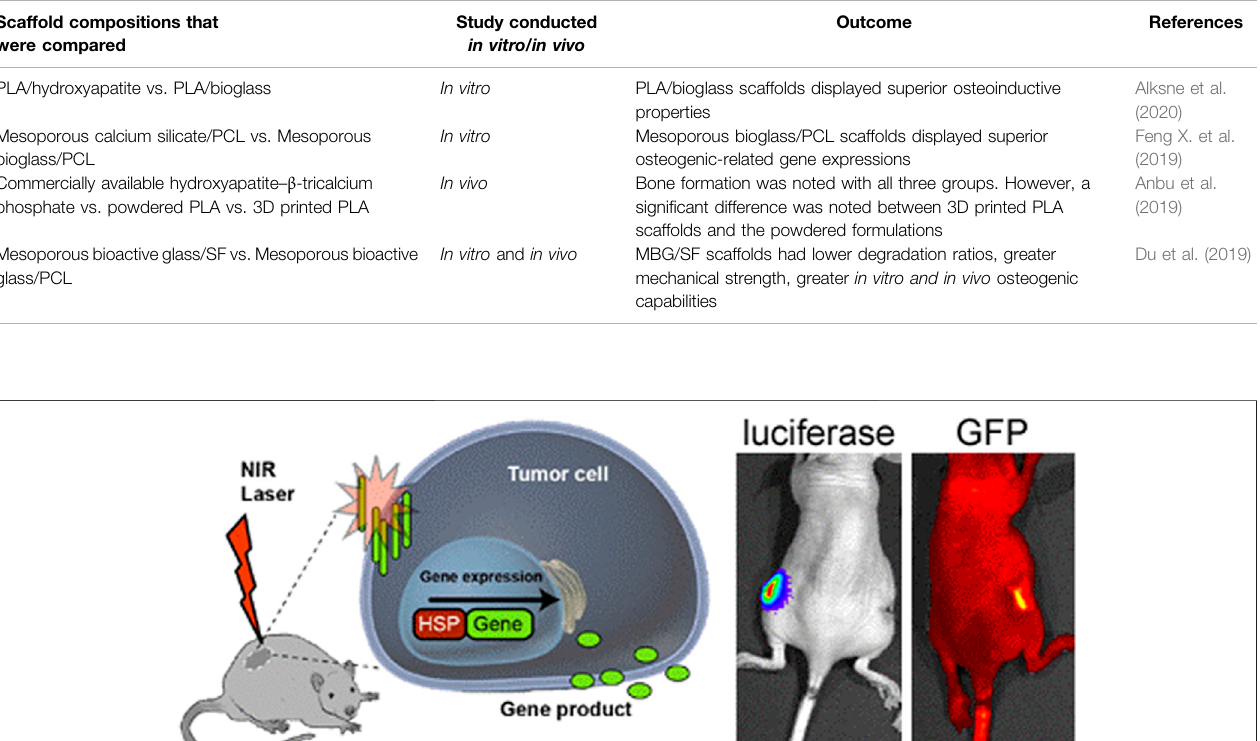
Frontiers in Materials |